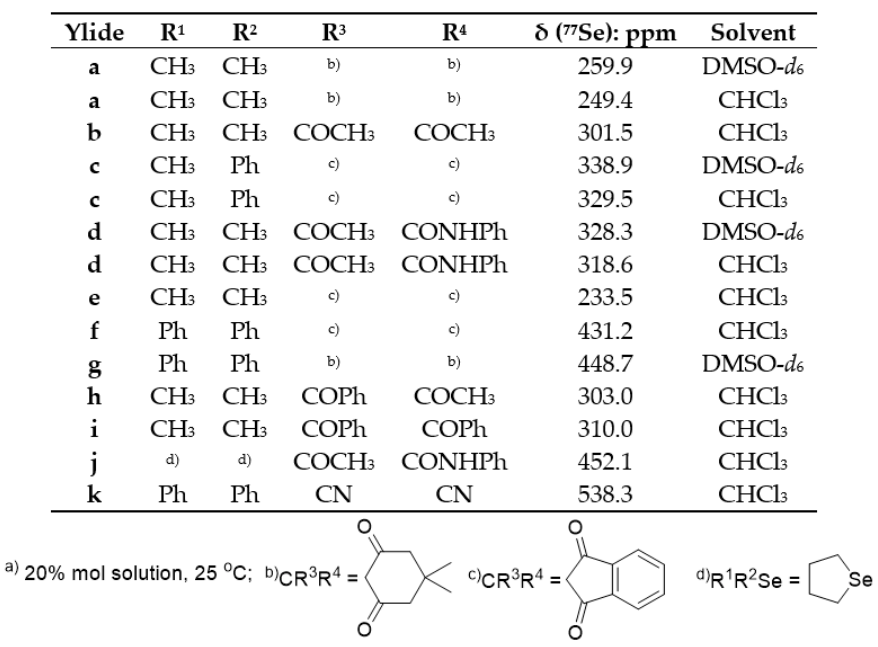
Figure 10. 77 Se chemical shifts of selenonium ylides 1 a) (R 1 R 2 Se + - - CR 3 R 4 ) (Me 2 Se as a reference).